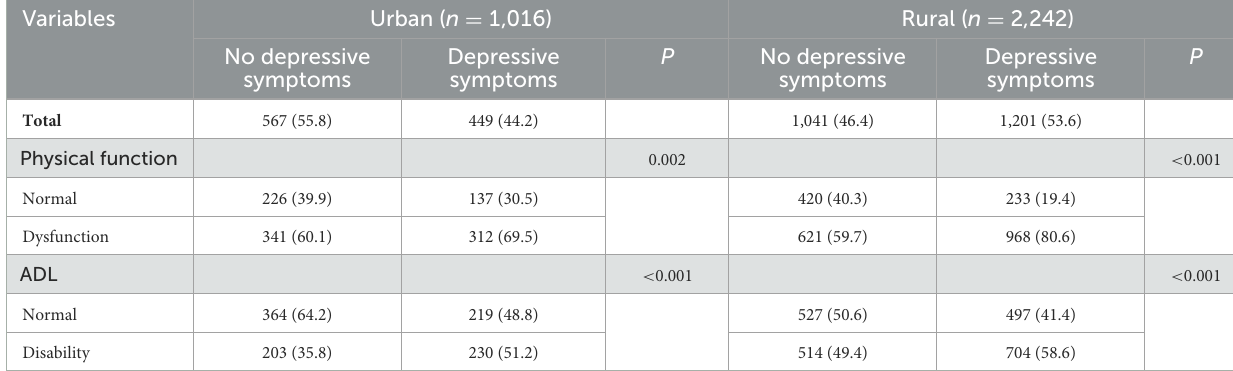
TABLE 3 Depressive symptoms based on urban and rural stratification of physical function and ADL in 2018 [N